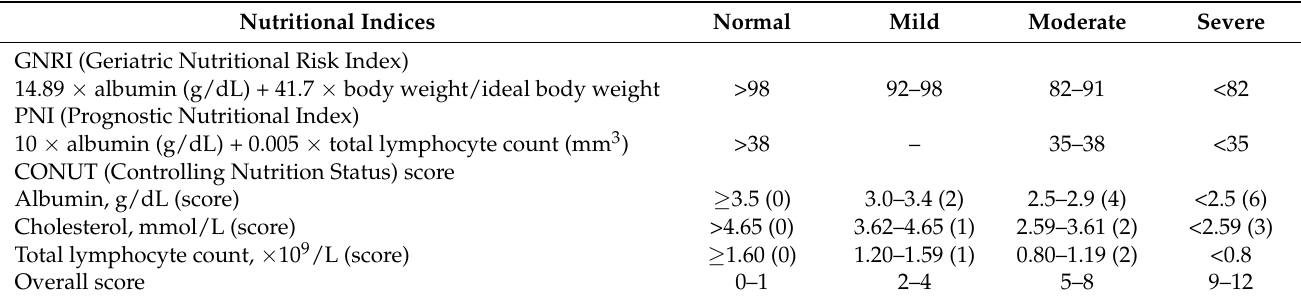
Table 1. Definition of nutrition indices used in this